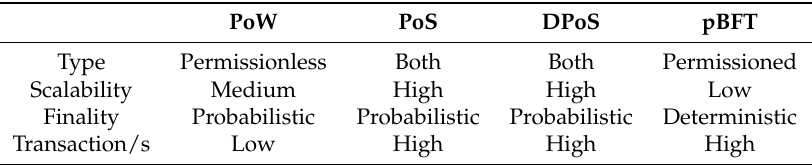
Table 2. General comparison between Consensus